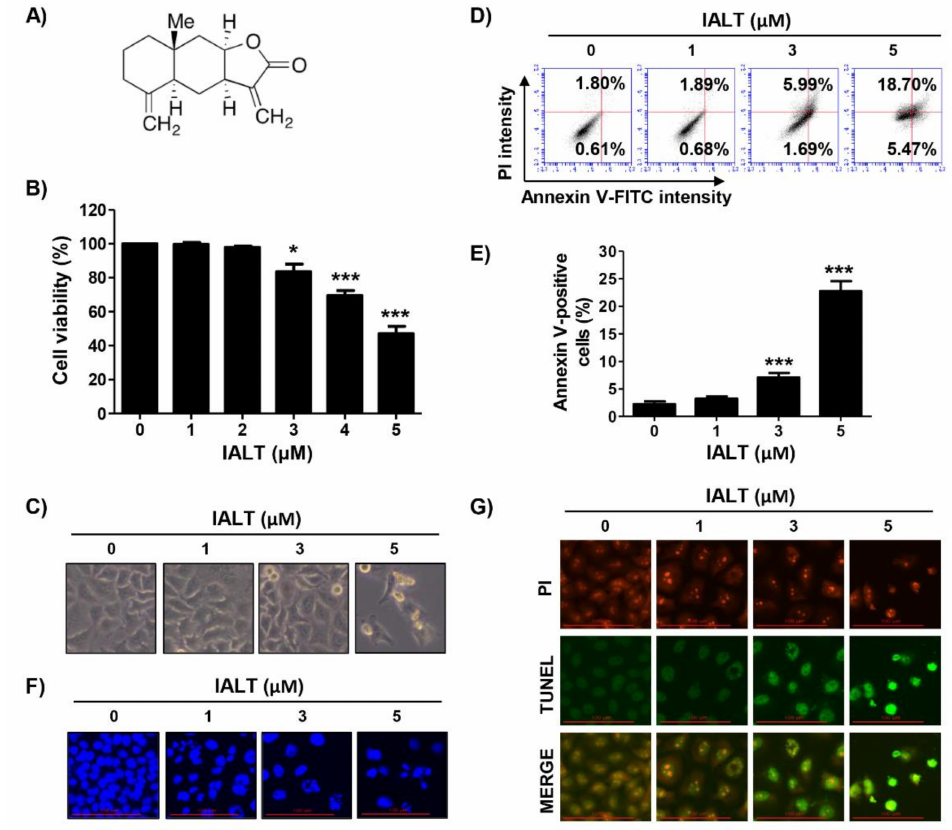
Figure 1. Inhibition of cell viability and induction of apoptosis by IALT in Hep3B cells. ( A ) Chemical structure of isoalantolactone (IALT). Cells were treated with the indicated concentrations of IALT for 48 h. ( B ) Cell viability was measured by the 3-(4,5-dimethylthiazol-2-yl)-2,5-diphenyltetrazolium bromide (MTT) assay. ( C ) Morphological changes were observed with a phase-contrast microscope. ( D , E ) Quantitative analysis of apoptosis induction by annexin V and propidium iodide (PI) staining was performed. ( D ) Representative profiles of flow cytometry results are presented. ( E ) The per- centage of apoptotic cells was expressed as a percentage of the total number of annexin V-positive cells. ( F ) Nuclear morphological changes were observed under a fluorescence microscope using 4 (cid:48) ,6 (cid:48) -diamidino-2-phenylindole (DAPI) staining ( × 400). ( G ) Representative images of terminal de- oxynucleotidyl transferase dUTP nick end labeling (TUNEL) staining in control and IALT-treated cells are presented ( × 400). TUNEL-positive cells are shown as green fluorescence. PI staining is shown as red fluorescence. ( B , E ) Data are expressed as the mean ± SD (* p < 0.05 and *** p < 0.001 compared to untreated